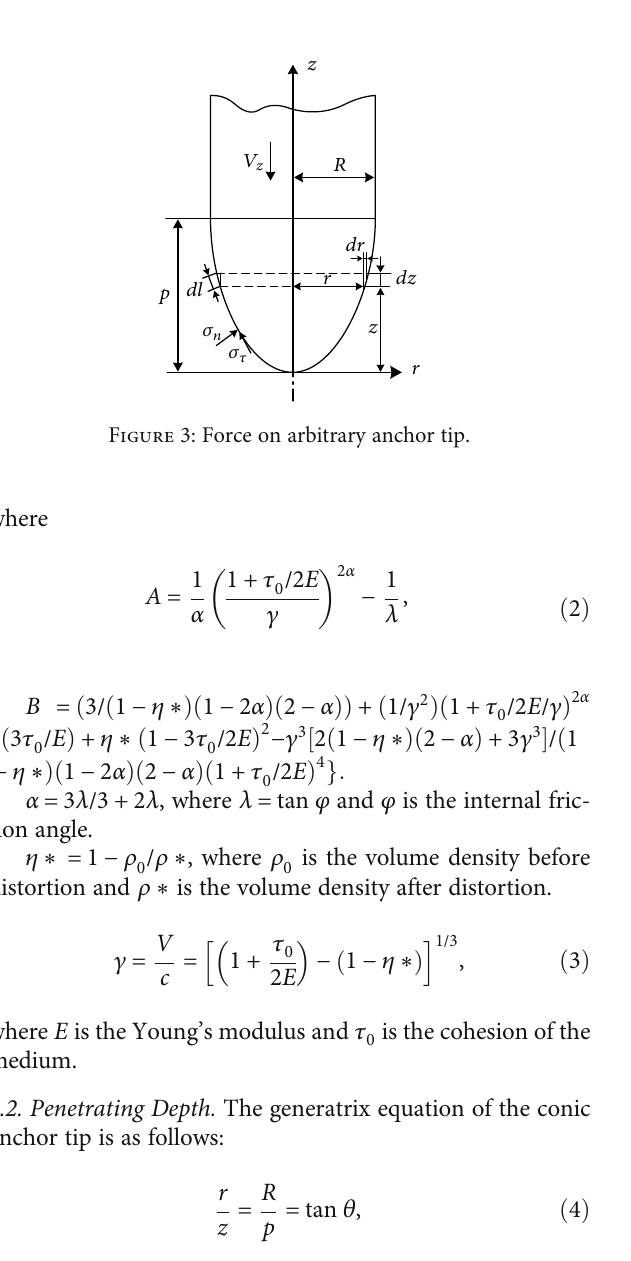
Figure 2: Schematic of the penetrating unit.